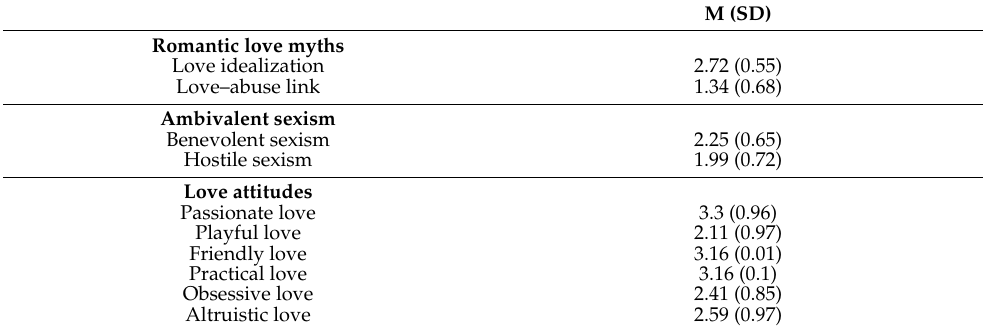
Table 2. Descriptive values of romantic love myths, ambivalent sexism, and love attitudes scales.